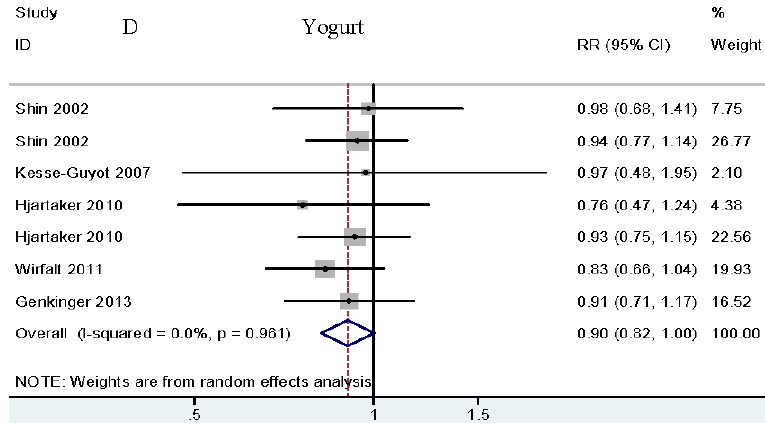
Figure 4. Relative risk of breast cancer for highest vs. lowest category of dietary protein sources intake. ( A ) Relative risk of breast cancer for highest vs. lowest category of processed red meat intake; ( B ) Relative risk of breast cancer for highest vs. lowest category of soy food intake; ( C ) Relative risk of breast cancer for highest vs. lowest category of skim milk intake; ( D ) Relative risk of breast cancer for highest vs. lowest category of yogurt intake. Overall, relative risk calculated with a random effects model. As shown in the figure, processed red meat ( A ) is related to an increased risk of breast cancer, whereas soy food ( B ), skim milk ( C ), and yogurt ( D ) are related to decreased breast cancer risk.